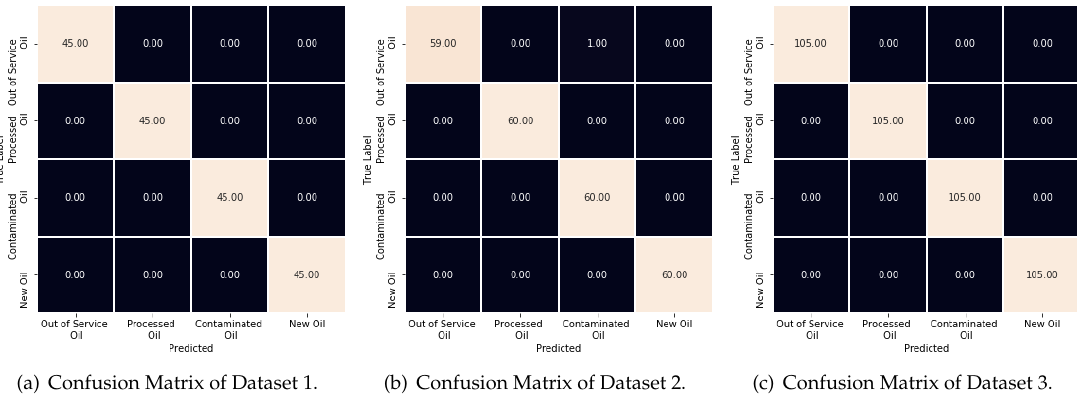
(a) Confusion Matrix of Dataset 1. (b) Confusion Matrix of Dataset 2. (c) Confusion Matrix of Dataset 3. Figure 12. Confusion Matrice of Classification Approach 1: ( a ) Dataset 1; ( b ) Dataset 2; and ( c ) Dataset 3.